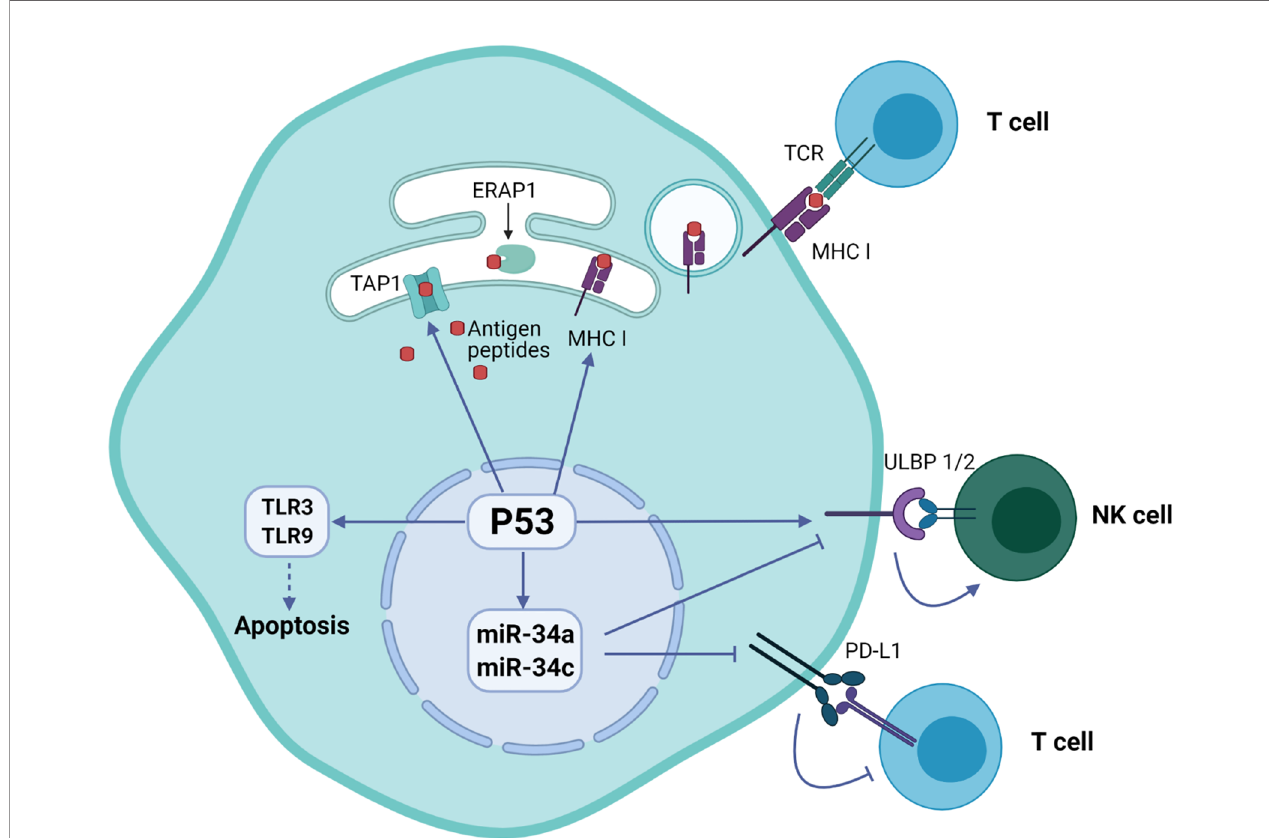
FIGURE 2 | Regulation of immune system functions by p53 protein in tumor cells. The p53 protein is involved in the presentation of endogenous peptides through regulation of TAP1 and ERAP1. In addition, p53 regulates the expression of NKG2D ligands ULBP1 and ULBP2, as well as inhibition of expression PD-L1 ligand through miR-34 microRNA precursor